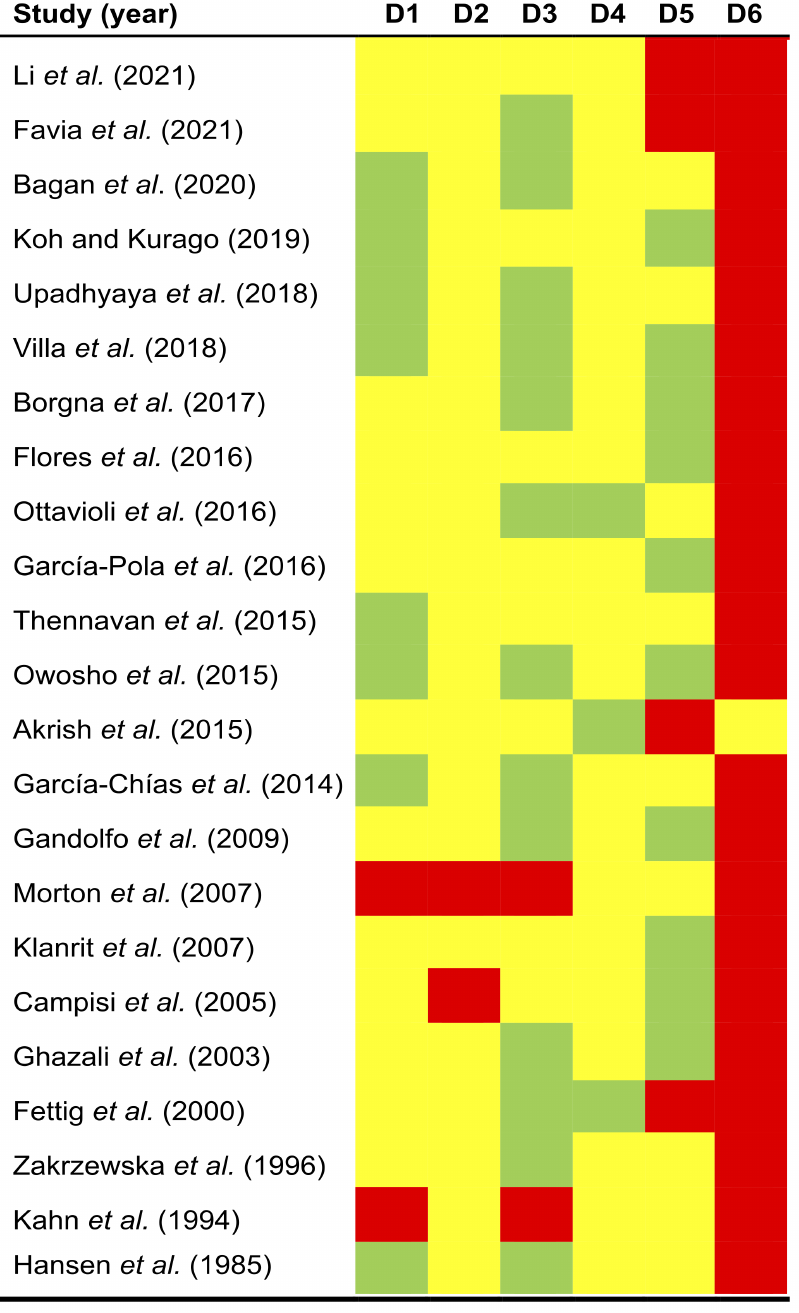
Figure 2. Quality plot graphically representing the risk of bias (RoB) analysis. The most relevant sources of bias were assessed in primary-level studies using the Quality in Prognosis Studies tool (QUIPS) -developed by Cochrane Prognosis Methods Group- across the following six domains: (D1) Study participation, (D2) Study attrition, (D3) Prognostic Factor Measurement, (D4) Outcome Measurement, (D5) Study confounding, and (D6) Statistical Analysis and Reporting. RoB was scored as low RoB (depicted in green colour), moderate RoB (yellow), or high RoB (red) for each domain. Statistical analysis and reporting . RoB was moderate in 4.35% of reviewed studies and high in 96.65% (Figure 2). The most frequent and relevant source of potential bias was